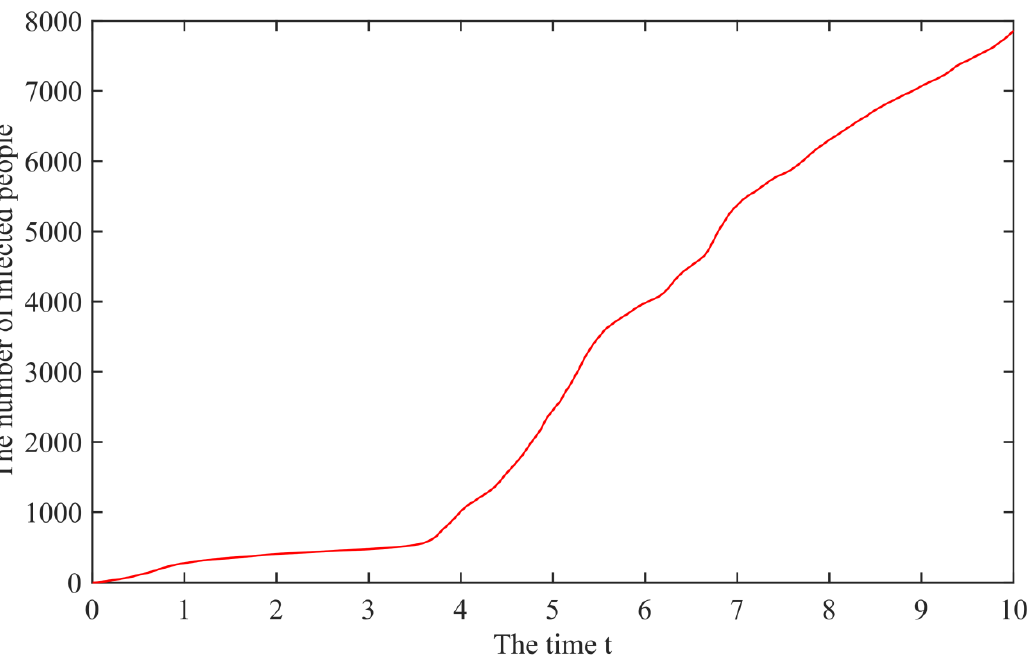
For the MBD infection, we present the number of infected people N p ( t ) as a function of time t for β = 0.01 in Figure 3. The curve shows a trend of sustained growth. It increases extremely slow because of the small mosquito population. Then, due to the sudden explosion of the mosquito population, the number of infected people rapidly increase.